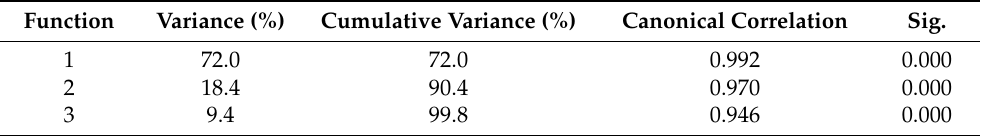
Table 5. Characteristics of typical discriminant functions of stepwise discriminant function analysis (DFA) of source group 1.